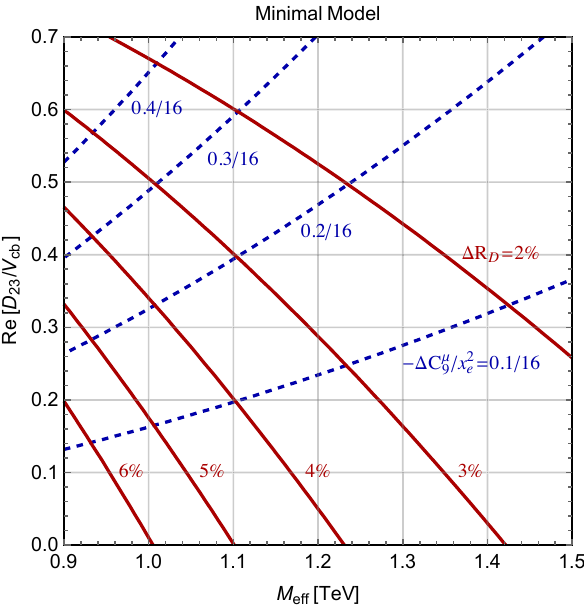
Figure 1 . Isolines of the charged current (CC, red solid lines) and of the neutral current (NC, blue dashed lines) anomaly in the minimal model for ∆ R 0 . 1 / 16 , 0 . 2 / 16 , 0 . 3 / 16 , 0 . 4 / 16 {